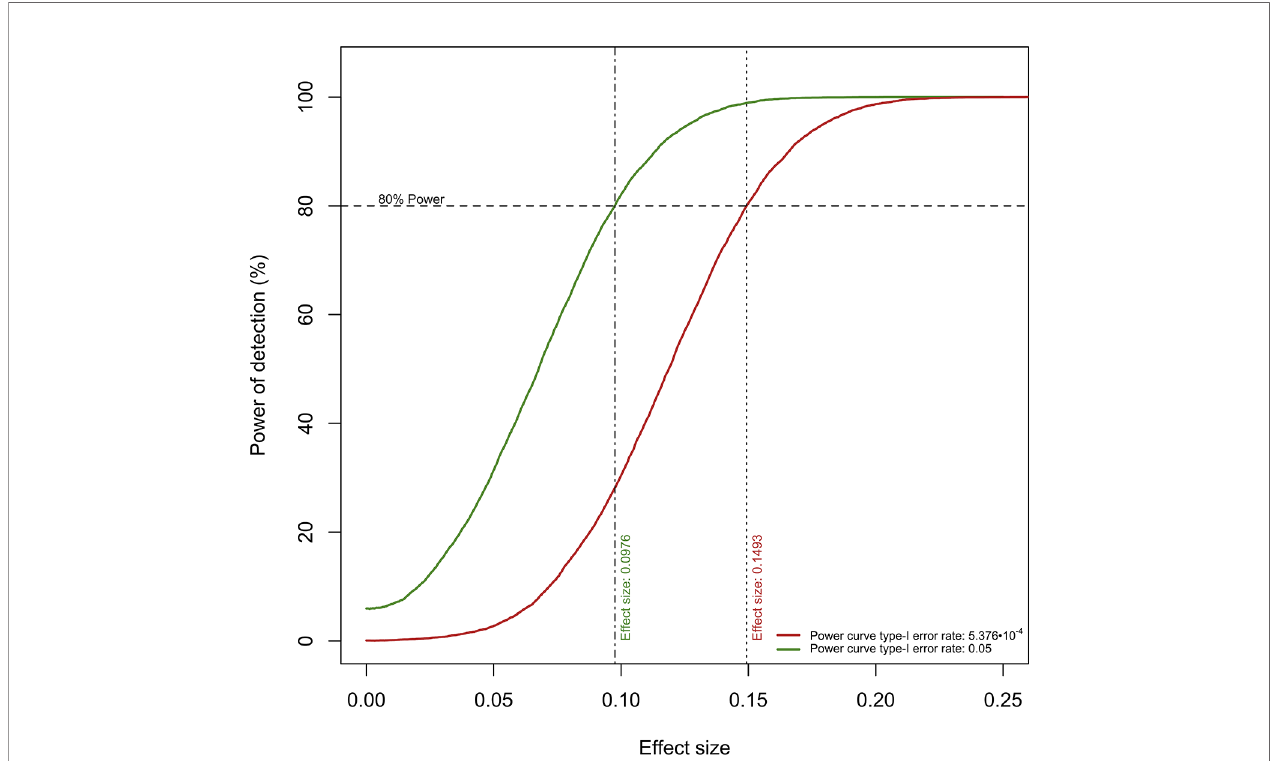
FIGURE 3 | Power curves for the detection of “ Time × Group ” coef fi cient values. The current sample size per experimental group confers ≥ 80% power to detect “ Time Group ” coef fi cients of ≥ 0.0976 (type-I error rate: 0.05) and ≥ 0.1493 (type-I error rate: 5.376 · 10 − 4